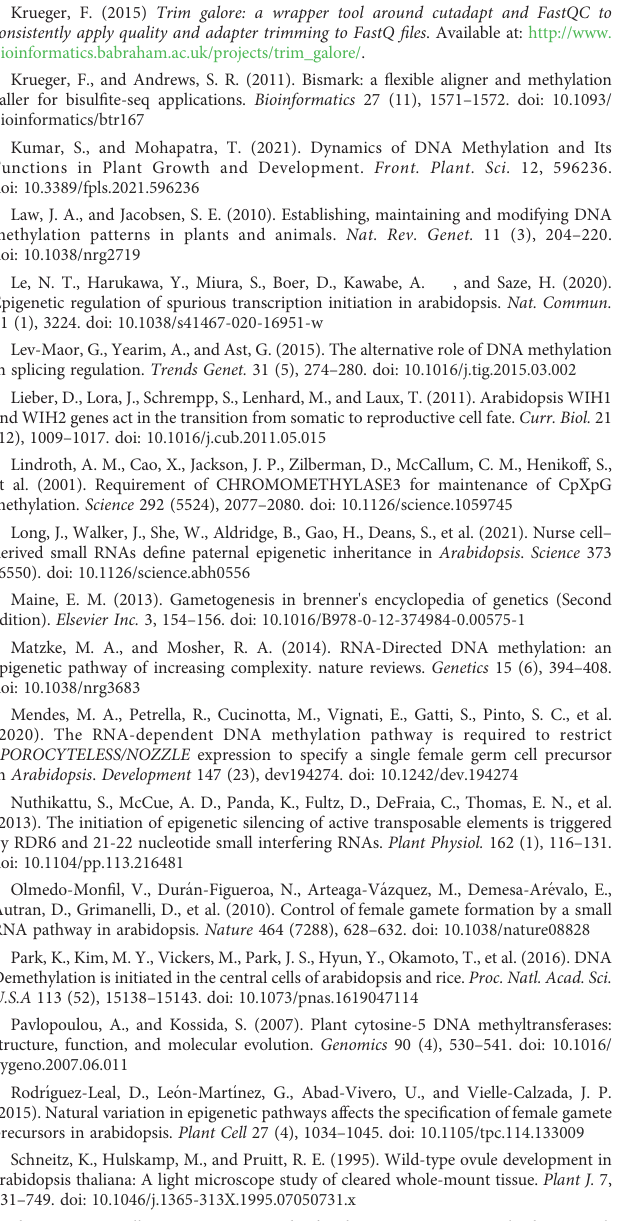
SUPPLEMENTARY TABLE 10 Annotated information of 11 genes potentially having a reproductive